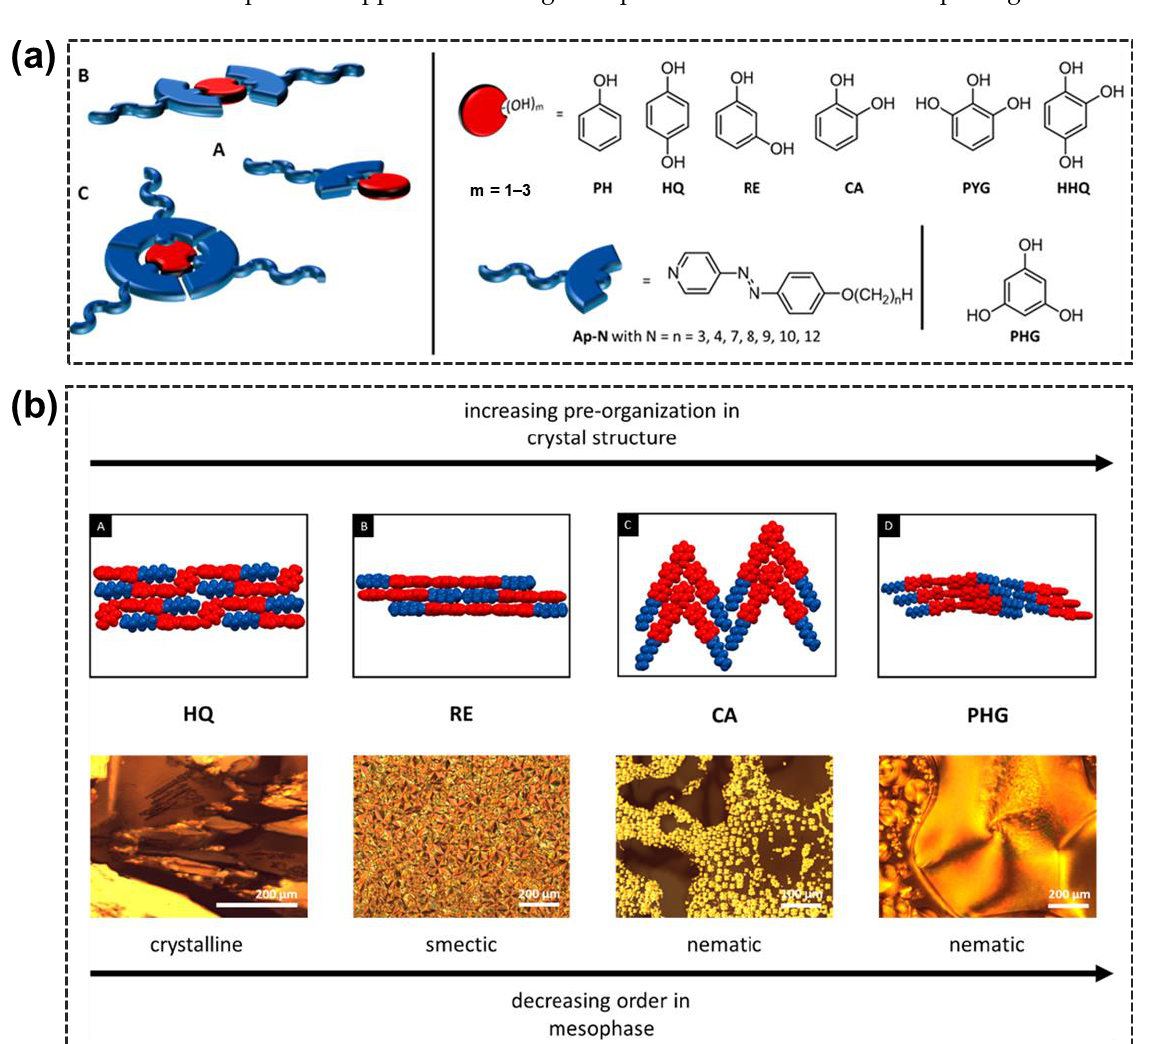
Figure 2. ( a ) Systematic study of hydrogen-bonded assemblies schematically drawn for 1:1 (A), 2:1 (B), and 3:1 (C) complexes. The used core units (red) phenol (PH), hydroquinone (HQ), resorcinol (RE), catechol (CA), pyrogallol (PYG), hydroxyhydroquinone (HHQ), and phloroglucinol (PHG) were mixed with azopyridine (blue) to form the HBAs. ( b ) Representative views of the intermolecular packing of HQ, RE, CA, and PHG assemblies (A–D, upper images), as observed with respect to the solid-state structures. The observations under cross-polarized microscope (lower images) show the correlation between the structural morphology and thermal behavior of the investigated hydrogen-bonded assemblies. Reprinted with permission from Reference [36] . Copyright 2017, American Chemical Society.